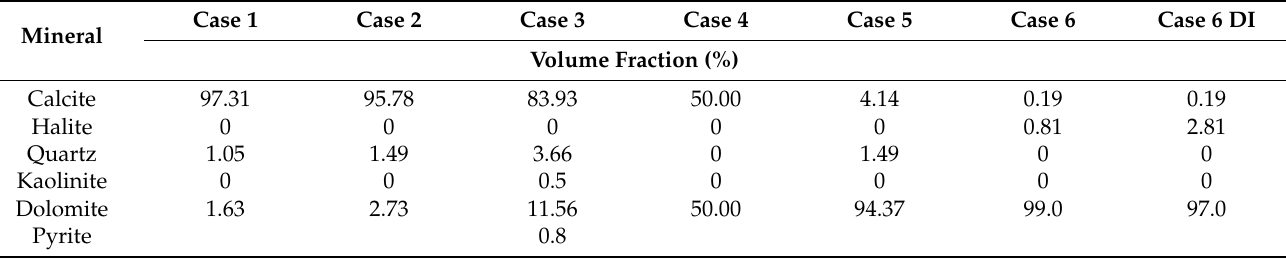
Table 3. List of initial mineral volume fractions.